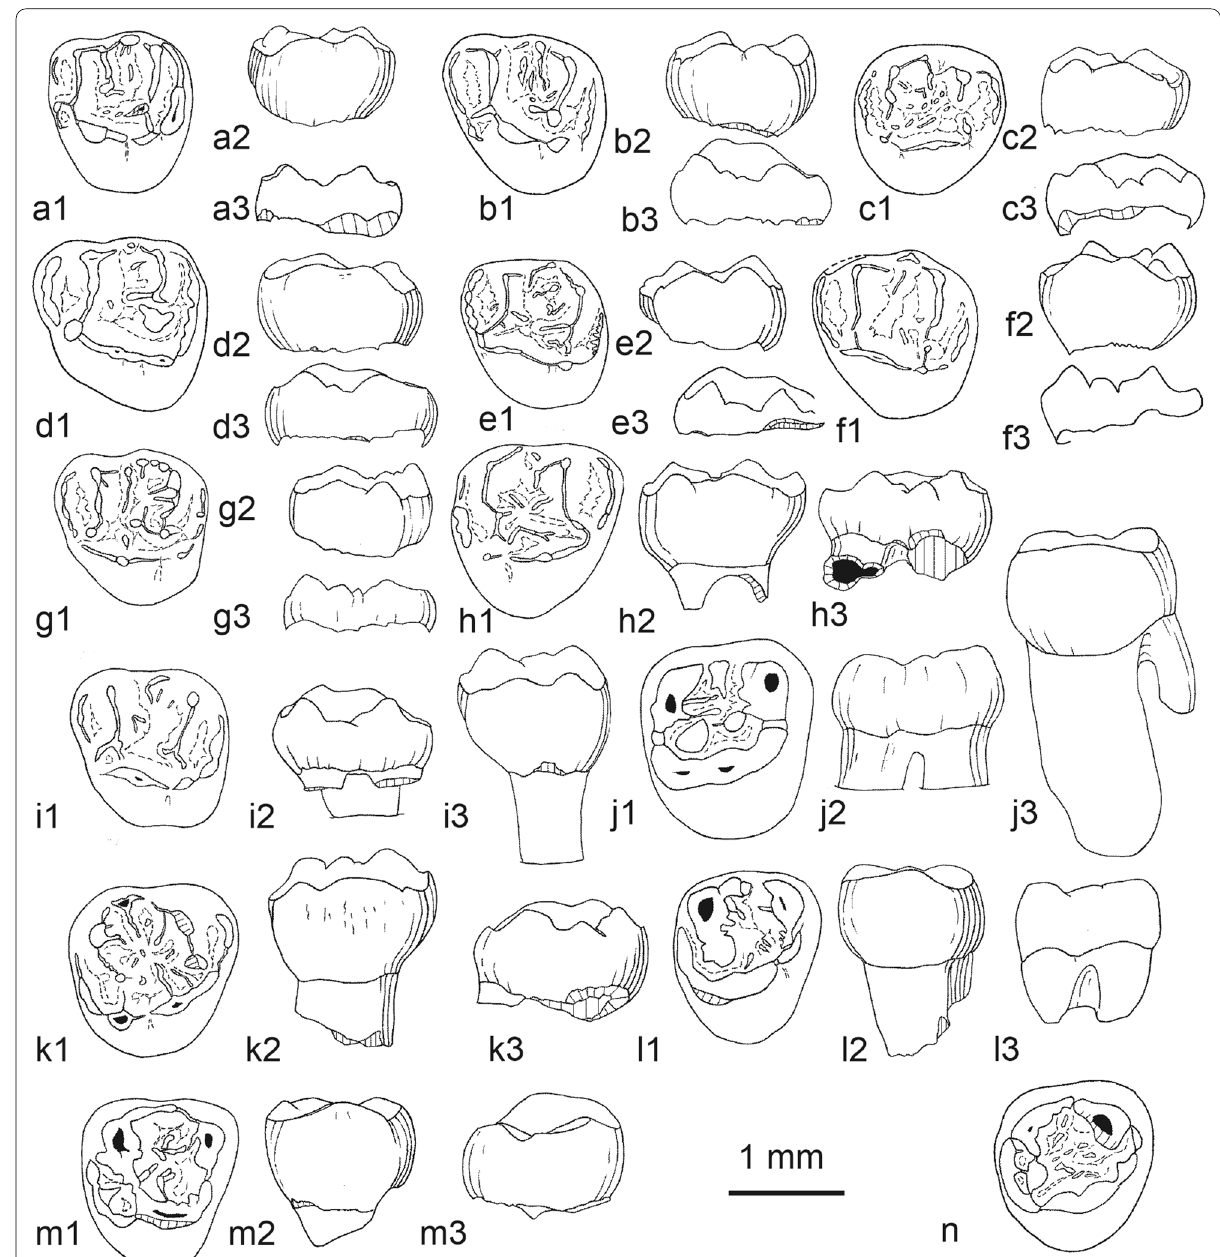
Fig. 45 Upper DP4 and P4 of ? Protadelomys maximini Escarguel, 1998 from Saint‑Maximin (Gard). a SMX1‑253 left DP4; a1, occlusal view; a2, lingual aspect; a3, buccal aspect. b SMX1‑254, left DP4; b1, occlusal view; b2, lingual aspect; b3, buccal aspect. c: SMX1‑255, right DP4; c1, occlusal view; c2, lingual aspect; c3, buccal aspect. d SMX1‑256, left DP4; d1, occlusal view; d2, lingual aspect; d3, buccal aspect. e SMX1‑257, left DP4; e1, occlusal view; e2: lingual aspect; e3, buccal aspect. f SMX1‑258, left DP4; f1, occlusal view; f2, lingual aspect; f3, buccal aspect. g SMX1‑260, left DP4; g1, occlusal view; g2, lingual aspect; g3, buccal aspect. h SMX2‑216, right DP4; h1, occlusal view; h2, lingual aspect; h3, buccal aspect. i SMX2‑217, right DP4; i1, occlusal view; i2, buccal aspect; i3, lingual aspect. j: SMX2‑218, right P4; j1, occlusal view; j2, buccal aspect; j3, lingual aspect . k: SMX1‑264, right DP4; k1, occlusal view; k2, lingual aspect; k3, buccal aspect. l: SMX1‑262, right P4; l1, occlusal view; l2, lingual aspect; l3, buccal aspect. m : SMX1‑263, right P4; m1, occlusal view.; m2, lingual aspect; m3, buccal aspect. n: SMX1‑265, right P4; occlusal view. Scale bar: 1